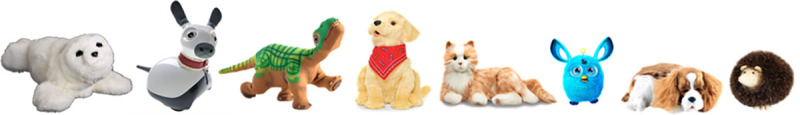
Eight robot and toy animals used in stage one.From left: Paro, Miro, Pleo rb, Joy for All dog, Joy for All cat, Furby Connect, Perfect Petzzz dog, Handmade Hedgehog.